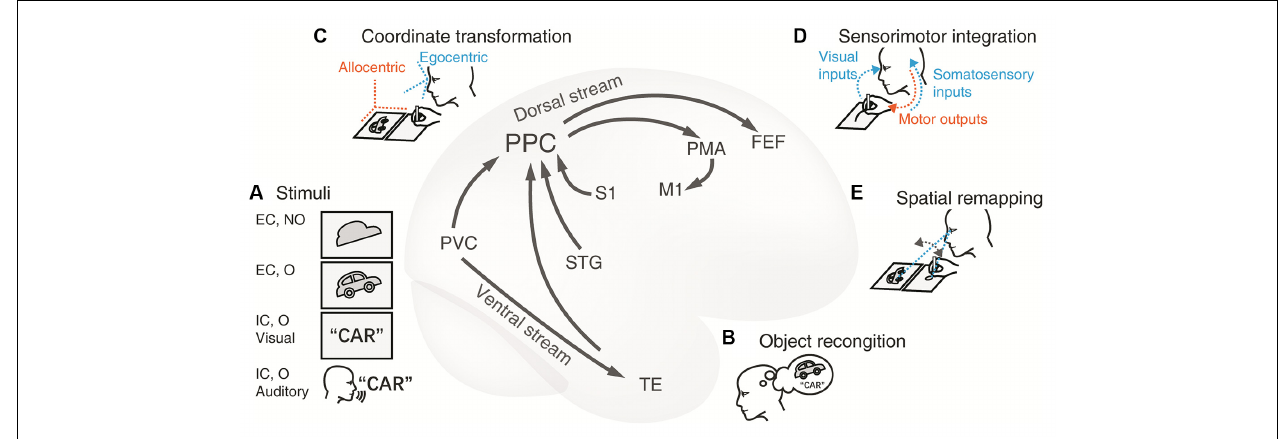
FIGURE 1 | Cortical neural circuitry underlying the visuospatial and sensorimotor functions of PPC in drawing tasks. (A) Stimuli. The first card with an irregular shape is an externally-cued nonobject stimulus and the contour of a car in the second card represents an external objective cue. The card with a word and the auditory instructions are instances of the internal cue of familiar objects. The primary visual cortex (PVC) and the superior temporal gyrus (STG) process the visual and auditory stimuli respectively. The information is subsequently conveyed to the adjacent PPC. (B) Object recognition. Transfer of object visual information to the temporal lobe through the ventral stream. The inferior temporal lobe is recruited to recognize and name the object presented. This conceptual information is then passed to the PPC through the connections between the dorsal and ventral streams. This extra procedure facilitates the construction of graphical representation to be drawn. (C) Coordinate transformation. The movement of limbs is encoded within the egocentric coordination, thus, the visual representation from the allocentric (world-centered) coordinate frame is transformed to an egocentric one (e.g., eye-centered or body-centered) in the PPC. (D) Sensorimotor integration. The PPC integrates multidimensional inputs of vision and somatosensory from the PVC and the primary somatosensory cortex (S1) respectively. These sensory inputs together determine the current position of the limb and provide guidance for planning and adjusting the trajectory toward the target on the canvas in the PPC. Then the premotor area (PMA) encodes the motor commands, and the primary motor cortex (M1) programs the motor signals and projects to the limb. As a result, the hand/pen moves to shape the final figure on the paper. (E) Spatial remapping. The PPC is communicated to the frontal eye fields (FEE) during saccades, which ensures the consistency of the graphical representations between the model and the copy. Abbreviations: EC, external cue; FEF, frontal eye fields; IC, internal cue; M1, primary motor cortex; MTL, medial temporal lobe; NO, nonobject; O, object; PMA, premotor area; PPC, posterior parietal cortex; PVC, primary visual cortex; S1, primary somatosensory cortex; STG, superior temporal gyrus; TE, rostral inferior temporal